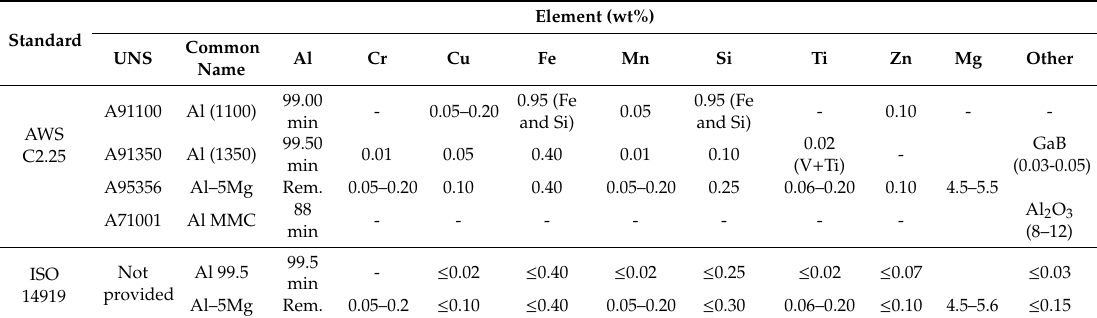
Table 3. Composition of wire feedstock reported in relevant codes and